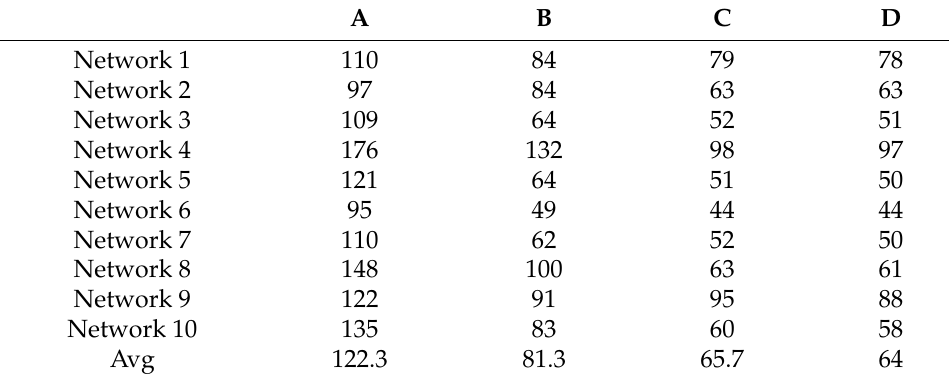
Table 3. Optimized frame sizes for medium networks.